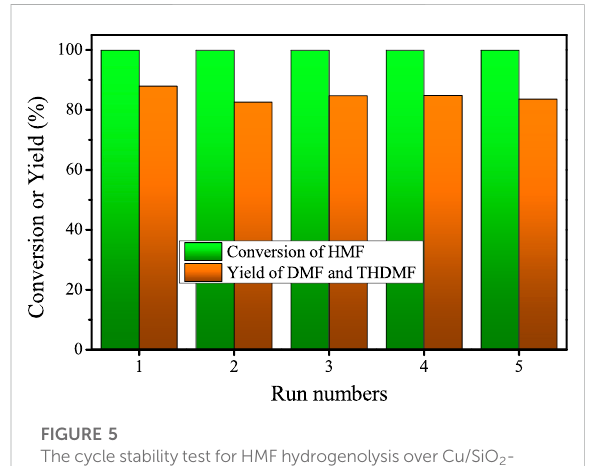
FIGURE 5 The cyclestability test forHMF hydrogenolysis over Cu/SiO 2